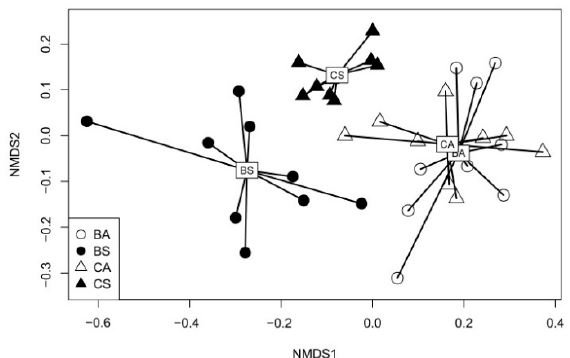
Figure 3. Nonmetric multidimensional scaling (NMDS) ordination plot of the dissimilarities in the collembolan assemblages in control and bioturbated plots.